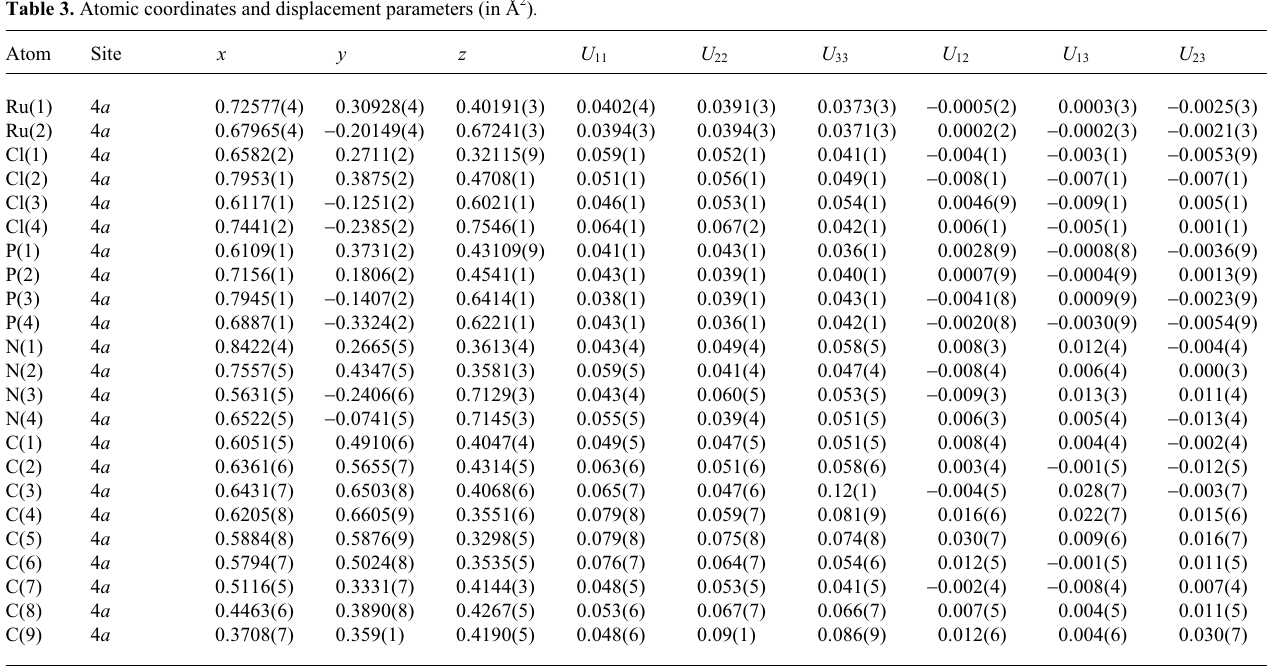
Table 3. Atomic coordinates and displacement parameters (in Å 2 ) .